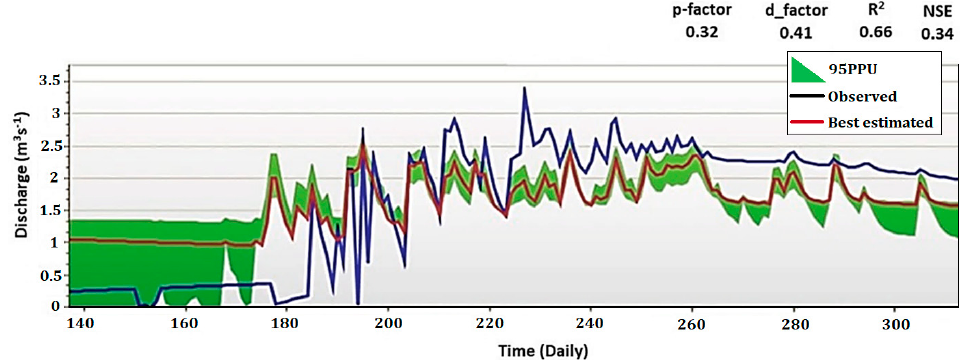
Figure A5. Observed and estimated discharge, 95% model uncertainty, and best approximation derived from SWAT after the calibration—original chart generated from SWAT Calibration and Uncertainty Program.